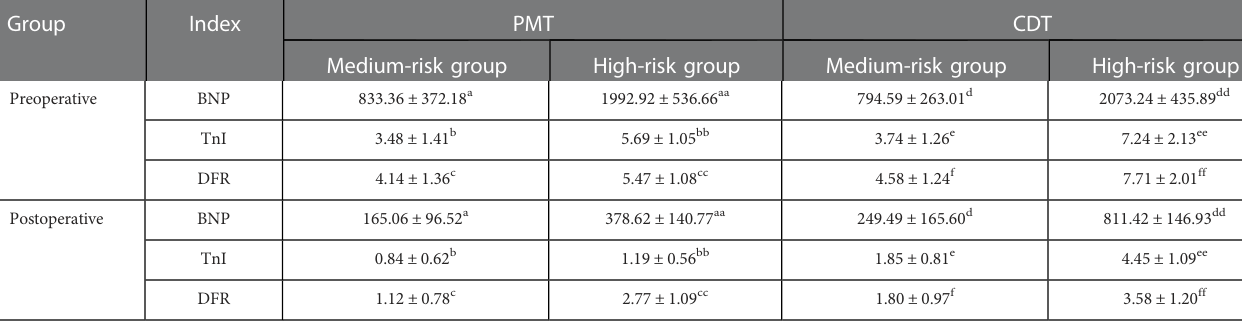
TABLE 2 Comparison of preoperative and postoperative serum BNP, TnI and DFR levels between two groups of APE patients. Group